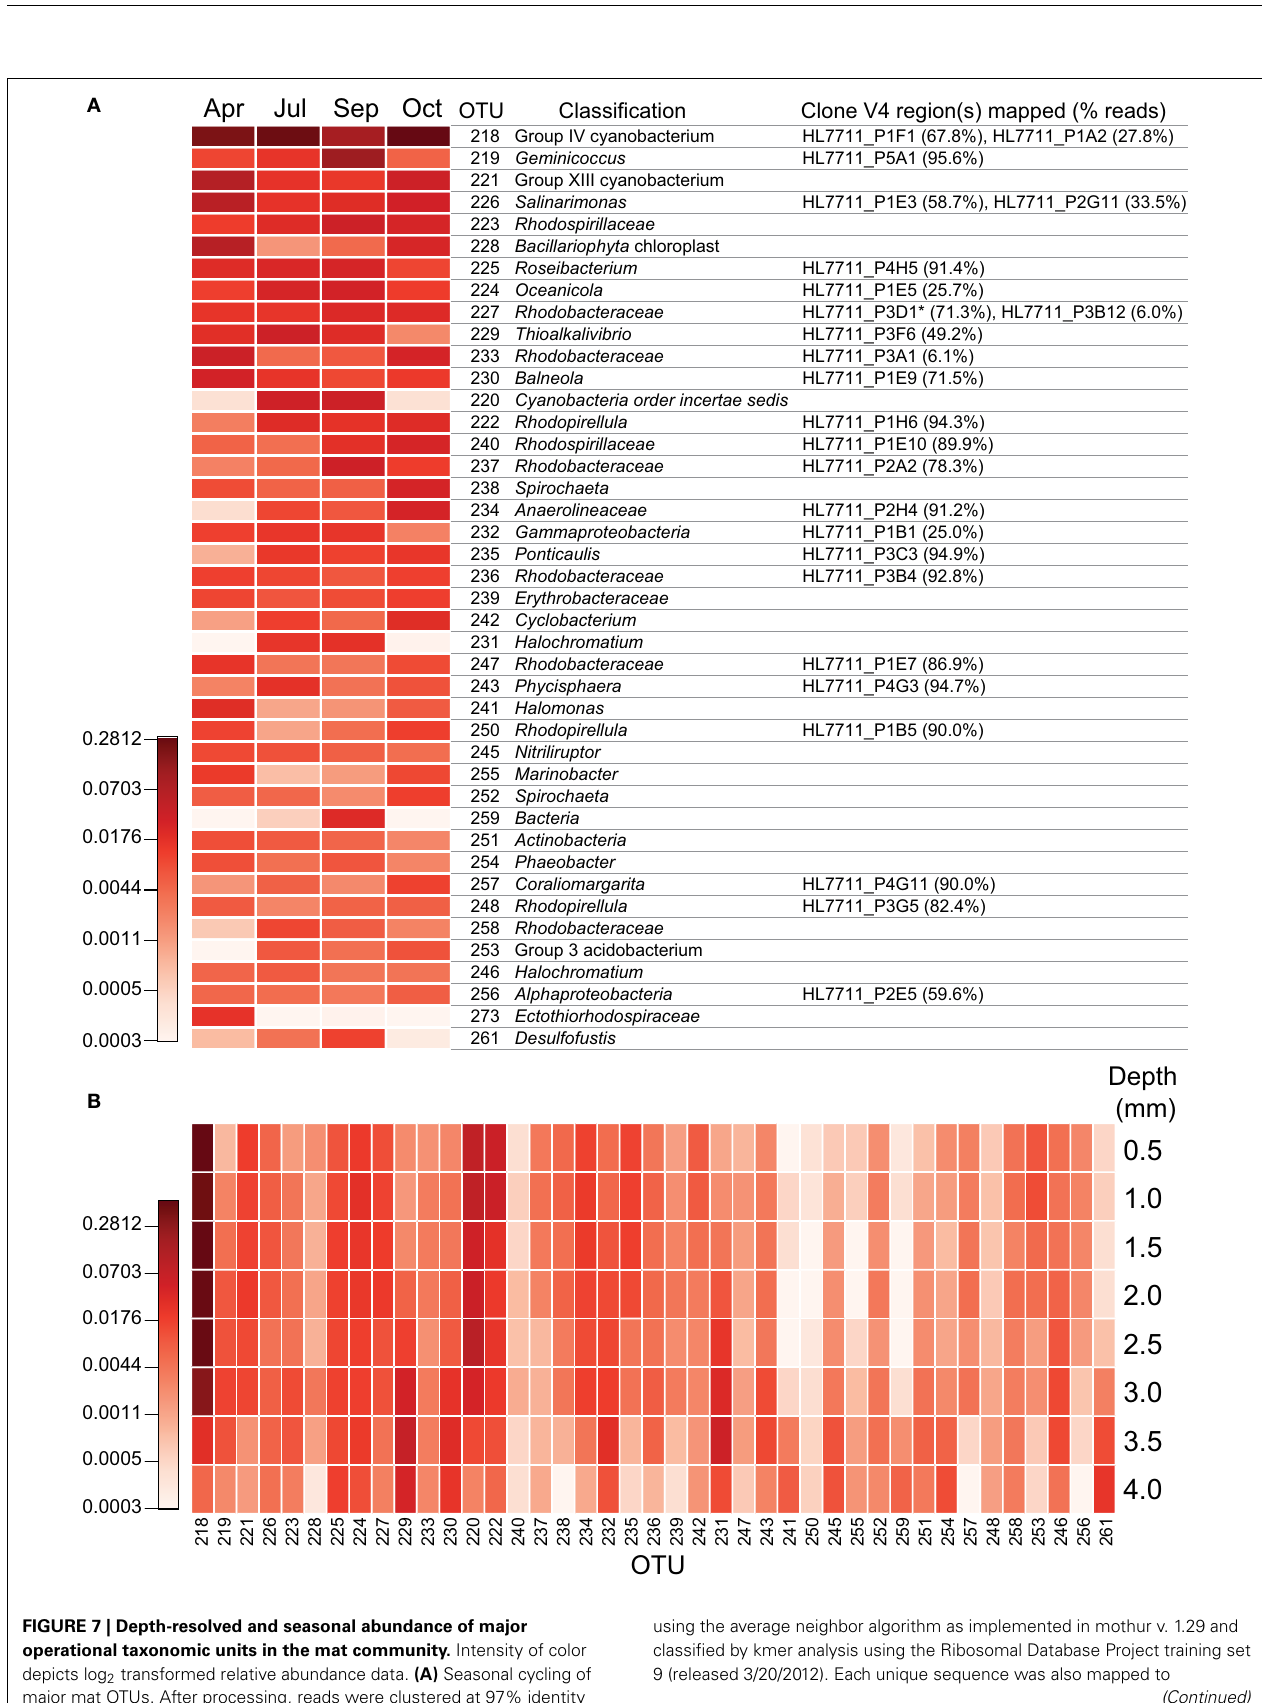
using the average neighbor algorithm as implemented in mothur v. 1.29 and classified by kmer analysis using the Ribosomal Database Project training set 9 (released 3/20/2012). Each unique sequence was also mapped to